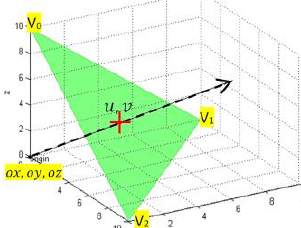
Figure 5. Ray-triangle